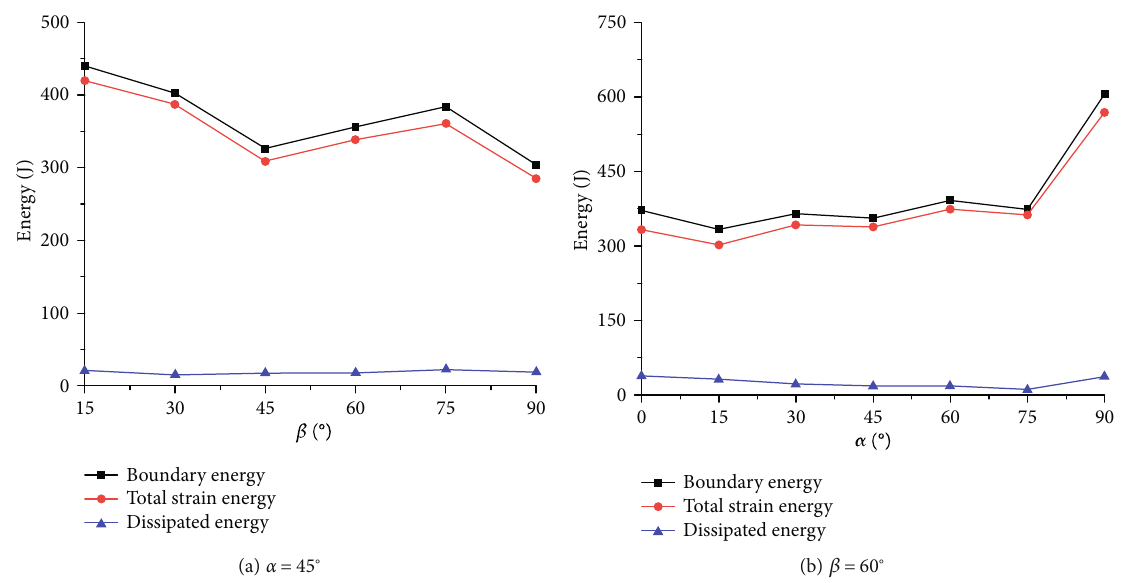
Figure 12: Change curves of energy indexes of numerical models containing X-shaped fi ssure in the peak